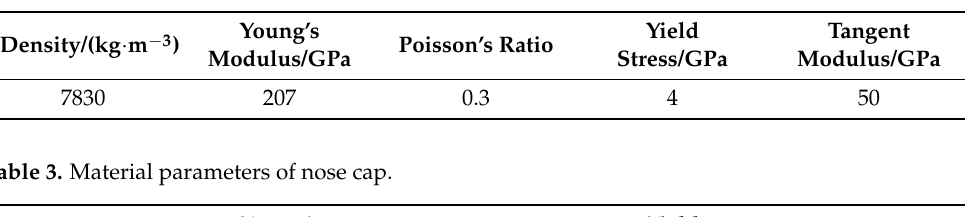
Table 2. Material parameters of connector.